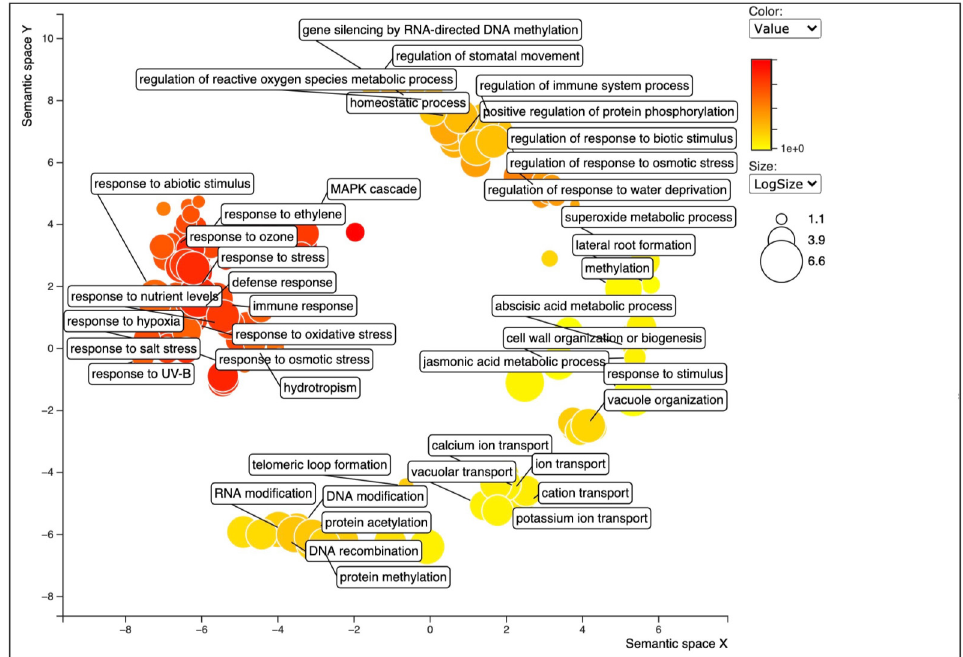
Figure 3. Biological process category of Gene Ontology (GO) enrichment analysis of upregulated transcripts of the oceanside trees, when compared with nr database using REVIGO. Circles in closer proximity have more closely related GO terms. The size of the circles indicates the number of GO terms. The color of the circle represents the significance of the enriched GO terms.